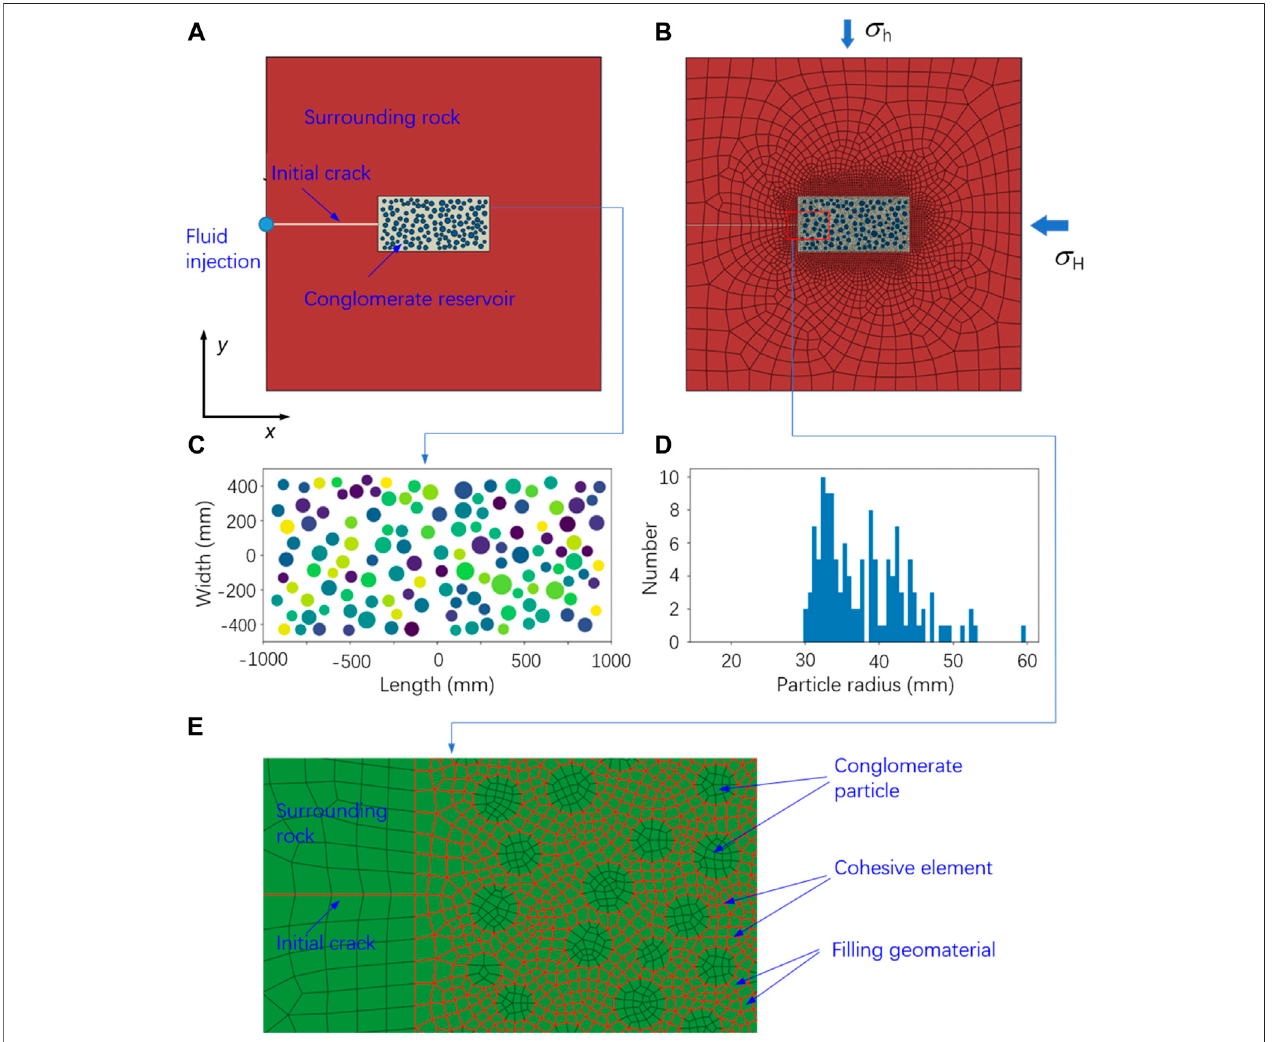
FIGURE2|(A) Planegeologicalmodel; (B) Planenumericalmodel; (C) Aggregatedistributionofconglomerate reservoirinthecorearea; (D) Statisticaldistribution oftheaggregatesizeoftheconglomeratereservoirinthecorearea; (E) Anenlargedpictureshowingthemeshesofconglomerateparticlesand fi llinggeomaterial,aswell as the cohesive elements embedded into the fi lling